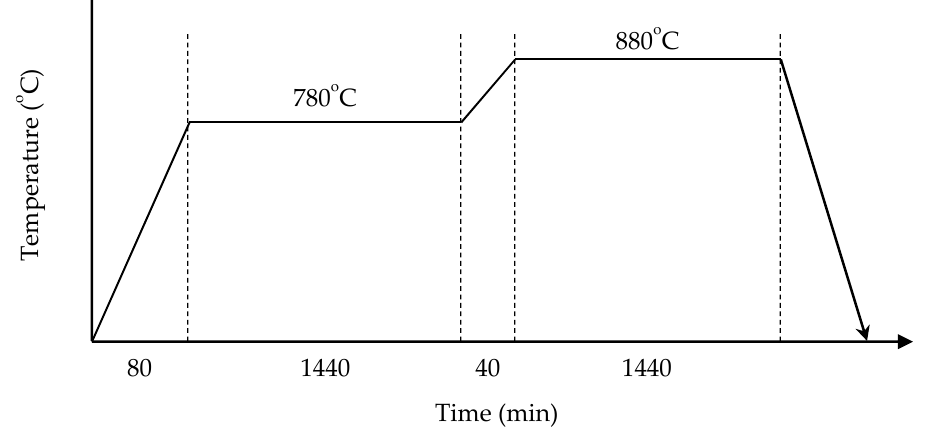
Figure 10. The variations in the heat treatment temperature and holding time (heat cycle) commonly adopted in the pilot furnace.